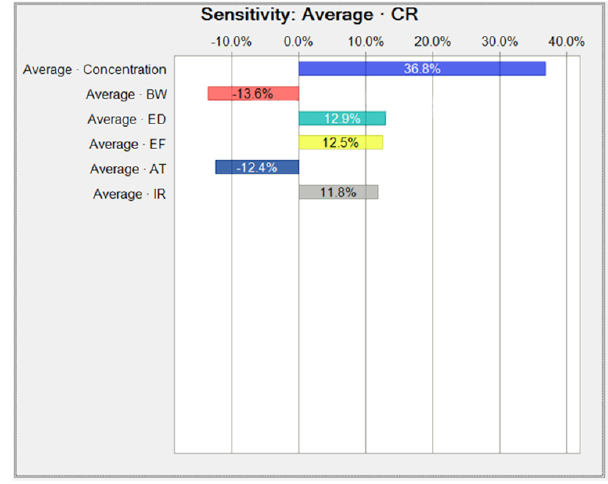
Figure A4. SA of LTCR model (children) for As in water.